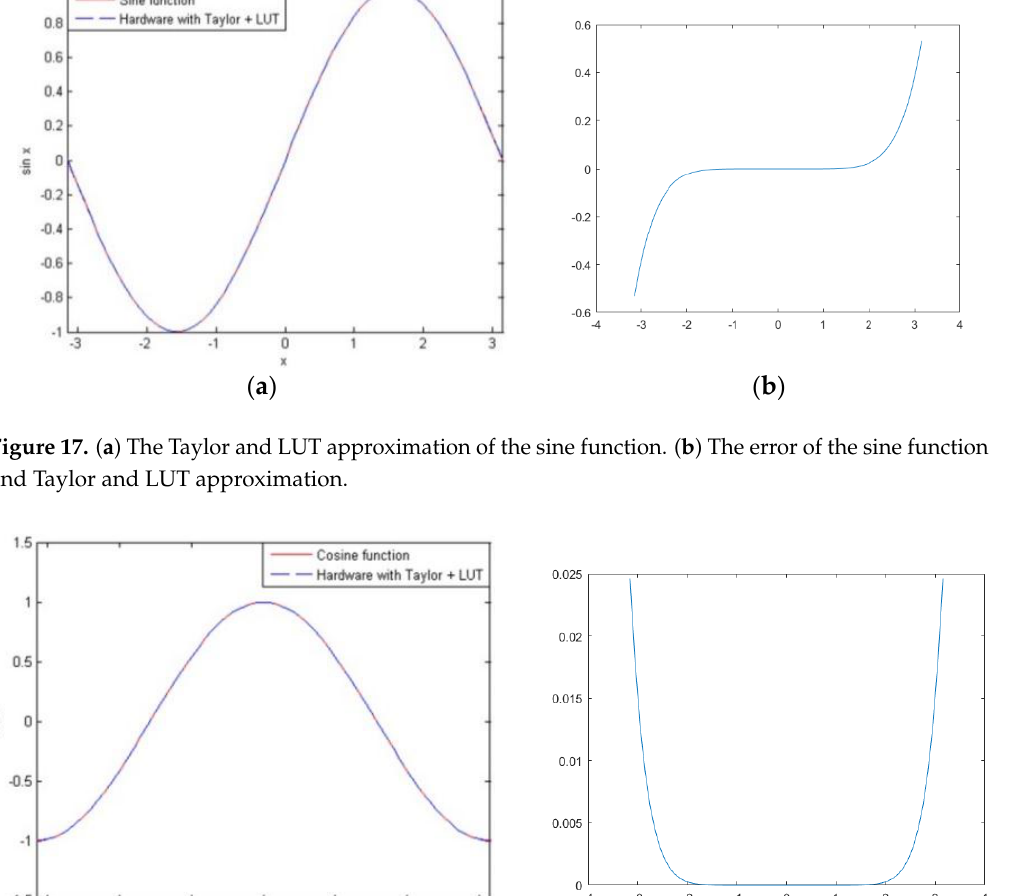
Figure 16. Block diagram of the cosine function with the Taylor expansion and LUT.